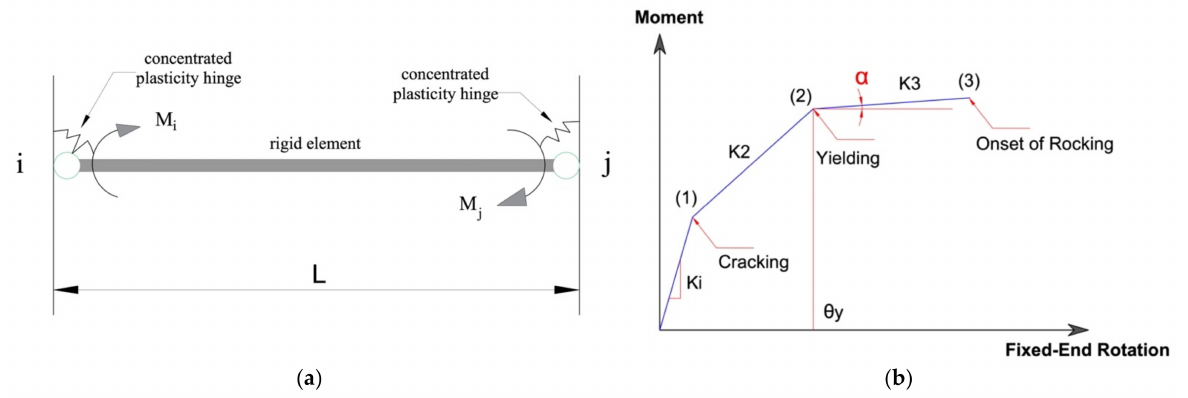
Figure 11. Analytical model for a beam–column element with fixed-end rotation: ( a ) concentrated plasticity hinges at beam ends and ( b ) a proposed moment–rotation relationship based on experimen- tal studies performed on full-scale beams